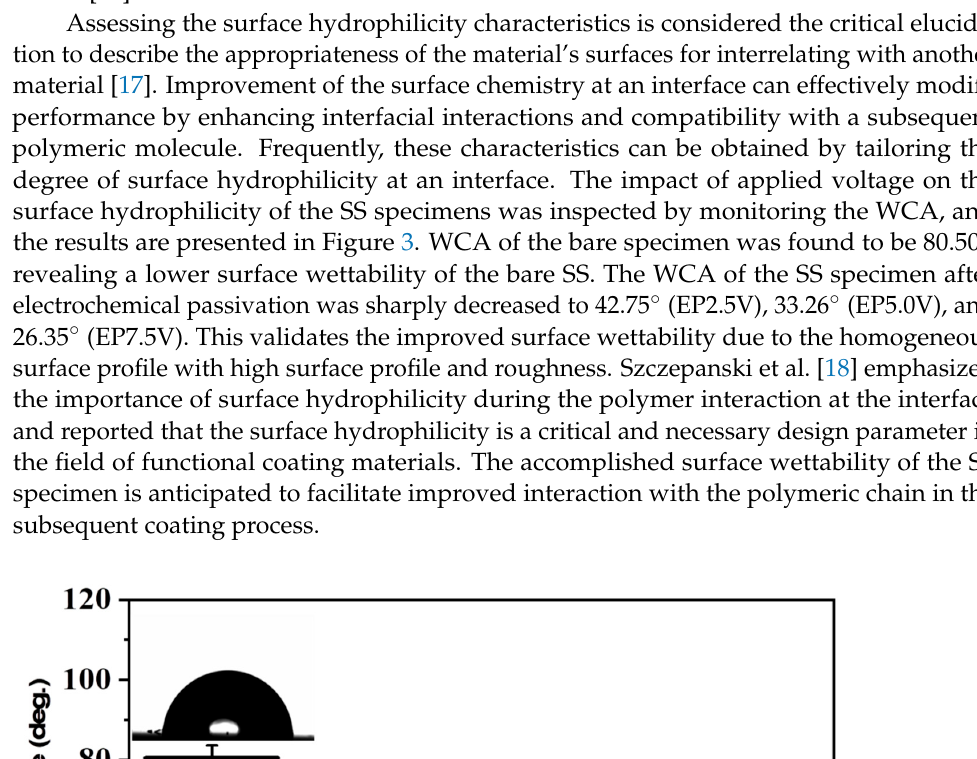
Table 2. Surface topographic and roughness parameters for the untreated and treated 316L SS spec- imens.